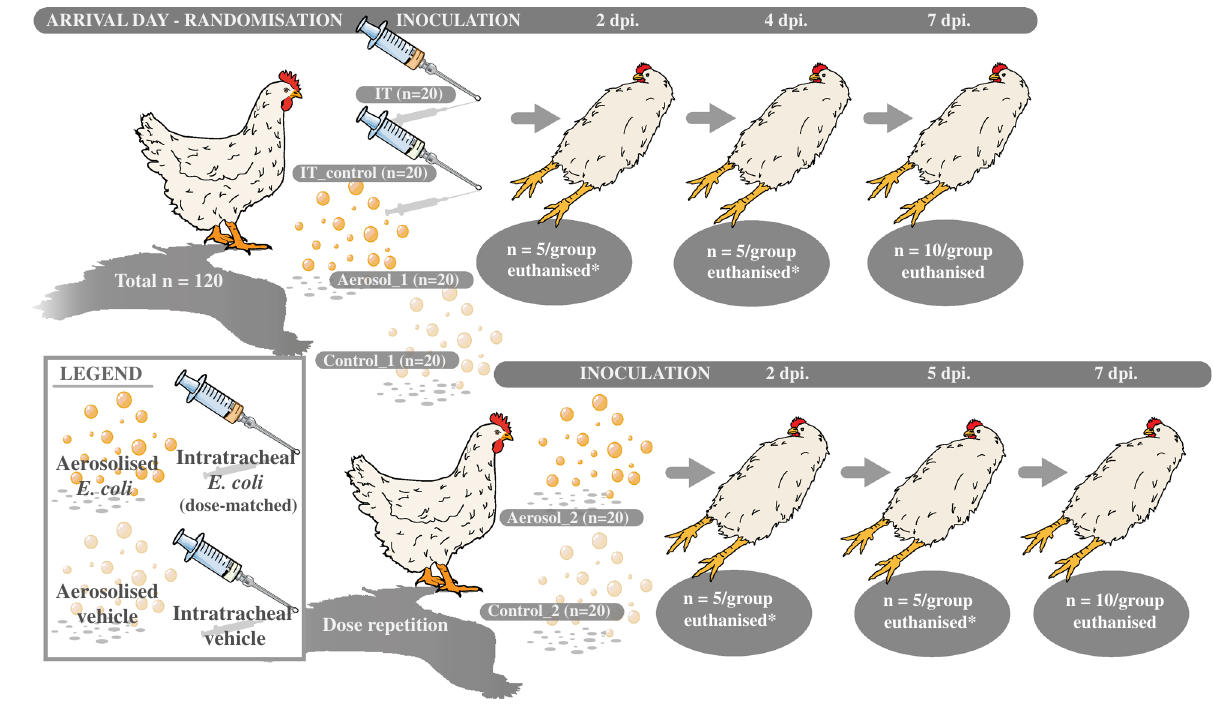
Figure 1. Study outline. Broiler breeder hens (n = 120) were allocated by randomisation to one of six groups and acclimatised for one week, and subsequently inoculated and euthanised according to the displayed timeline. *Animals were designated for euthanasia by randomisation, and deviations from the schedule only occurred if animal welfare considerations made premature euthanasia necessary. Aerosol inoculation was replicated at alternating days to evaluate the reproducibility of the results obtained through this route of infection. An intratracheally inoculated group was initially included as a positive infection control. dpi days post-infection; n number; IT